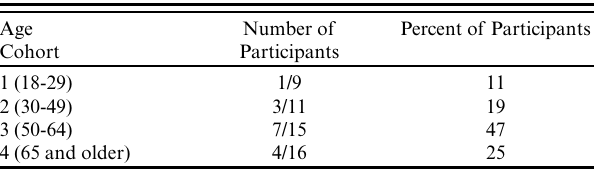
Table 6 . Observations of changing spring conditions by age